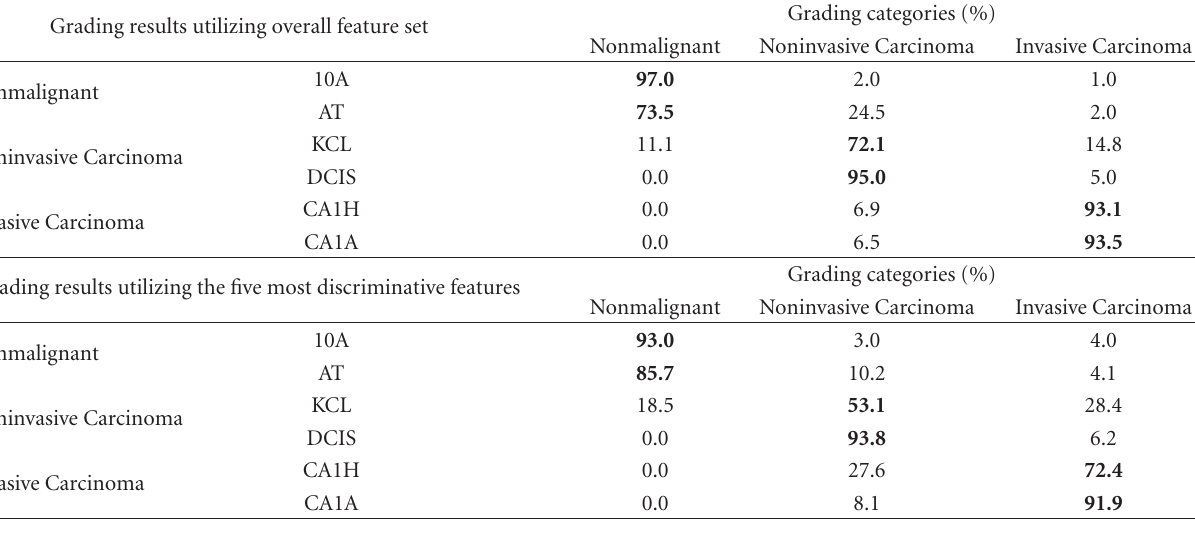
Table 3: Performance of the SVM-based classifier with the proposed quantitative features. Acinar structures are graded as nonmalignant as trained from the 10A and AT samples, noninvasive carcinoma as trained from the KCL and DCIS samples, and invasive carcinoma as trained from the CA1H and CA1A samples using all of the proposed features as well as the five most discriminative features: continuity of integrin α 6 along the basal membrane, colocalization of integrin α 3 with integrin α 6, integrin α 3 density, ratio between hollow lumen and acinar structure areas, and integrin α 6 density. The data set includes 400 acinar structures: 99 10A, 49 10AT, 81 KCL, 80 DCIS, 29 CA1H, and 62